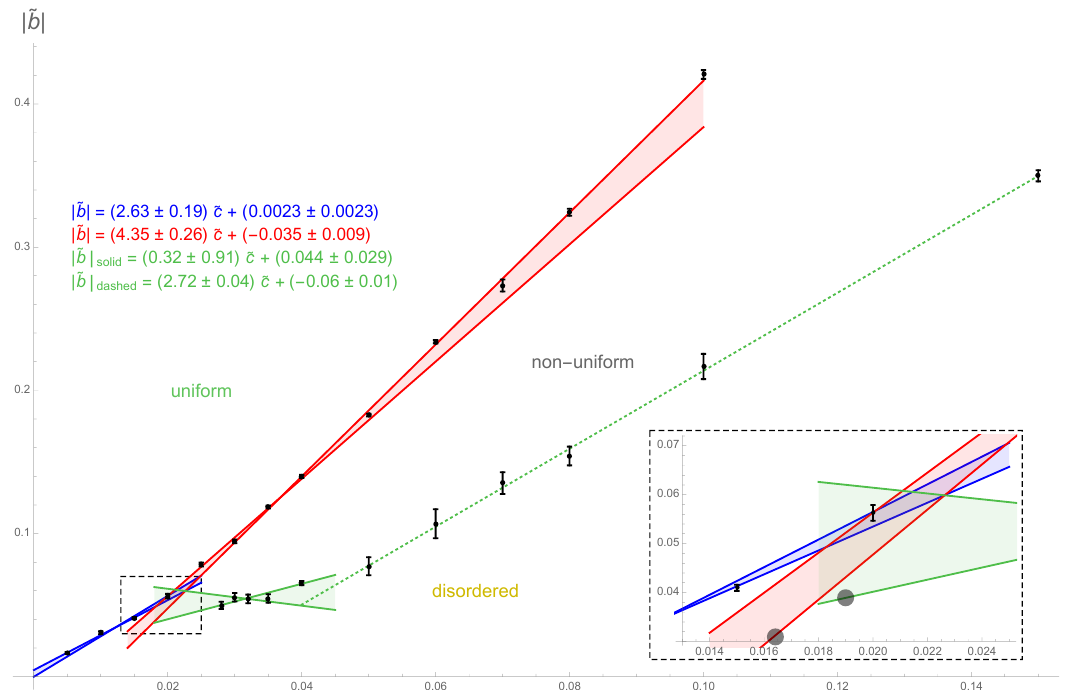
Figure 5 . Phase diagram obtained by (cid:12)rst extrapolating the phase transition points ~ b (~ c ) as N ! 1 and then by (cid:12)tting the lines close to the triple point. There are two or three curves for each of the transition lines because their slopes change as the triple point is approached. The coloured region is bounded by two lines | one obtained by (cid:12)tting only the nearest well-resolved points, the other using also more distant ones; the correct phase transition lines should be bounded by those lines. table 1. The matrix sizes used di(cid:11)er for each of the points, but were in the range 8 (cid:20) N (cid:20) 127. The three bounding curves meet (within errors) in the vicinity of the point: ~ c = 0 : 0226, j ~ b j = 0 : 0599. The grey points in the zoomed plot mark the estimates obtained using the two other methods. The lines quoted in the upper left corner of the main (cid:12)gure are colour coded and refer to those in the zoomed